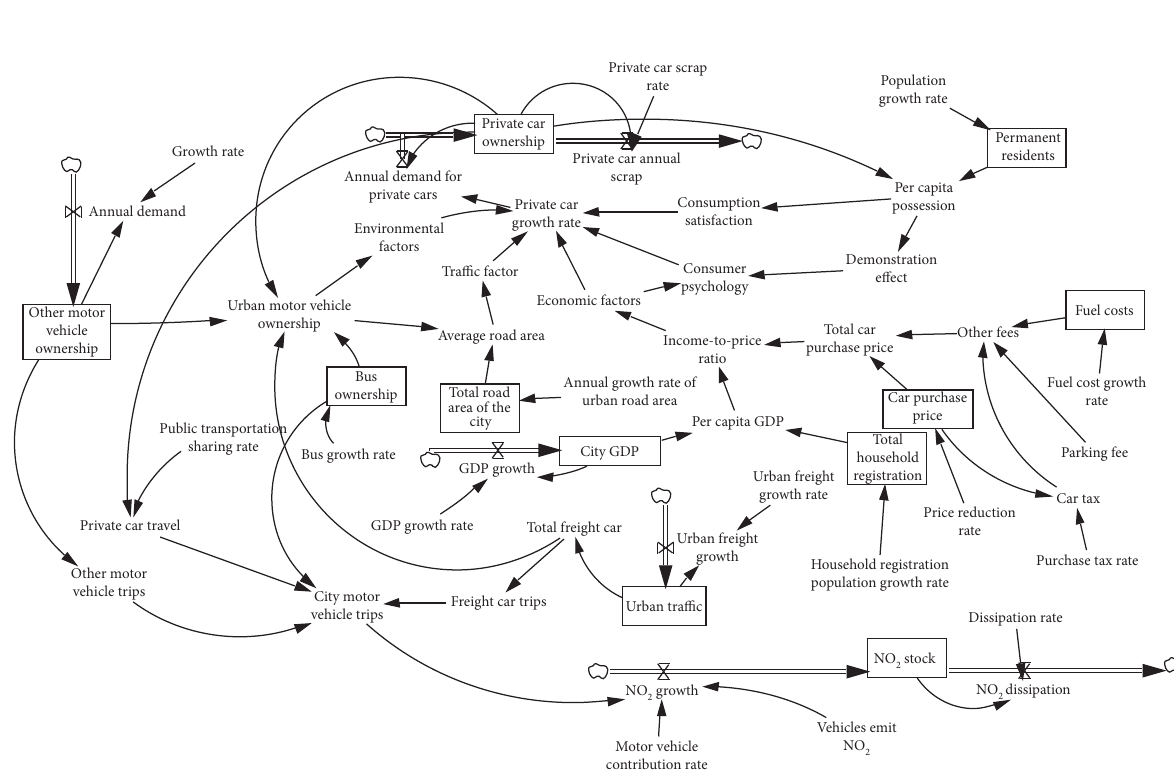
Figure 2: Causal cycle diagram.